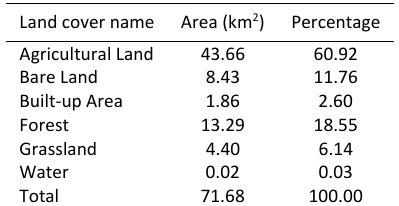
Table 3: Area and percent per land cover in Malingon River basin